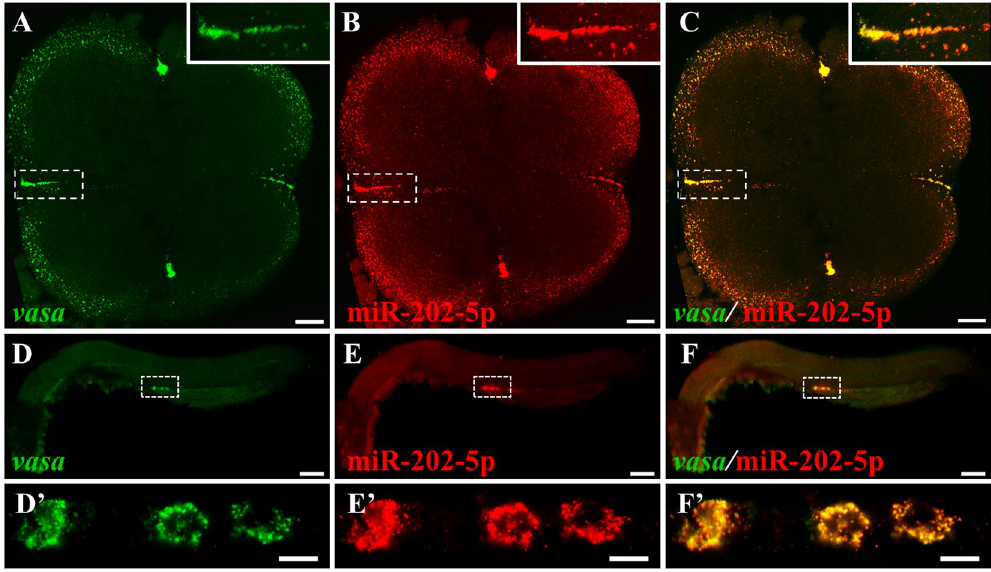
Figure 4. Co-localization of miR-202-5p and vasa mRNA by FISH. ( A and D ), vasa mRNA (green), ( B and E ) miR-202-5P (red); ( C and F ), merged. ( A – C ), embryo at 4-cell stage; D–F’, embryo at prim-5 stage. The smaller panels on top right of ( A – C ) indicated the high magnification of the white dotted areas, and D’–F’ are the high magnification of the white dotted areas in ( D – F ). Scale bars: 50 μ m in ( A – C ), and 100 μ m in ( D – F